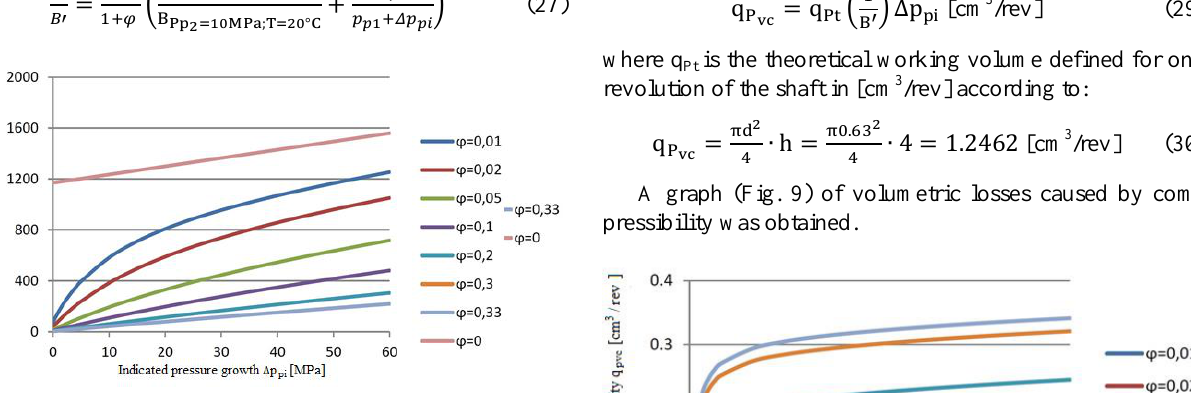
Fig.7. The bulk modulus B depends on the indicated pressure of the pump, where φ = 0 means pure diesel oil, φ > 0 means diesel fuel with gas in certain ratios, φ = 0.33 determines the volume ratio for the example of a hypocycloidal pump